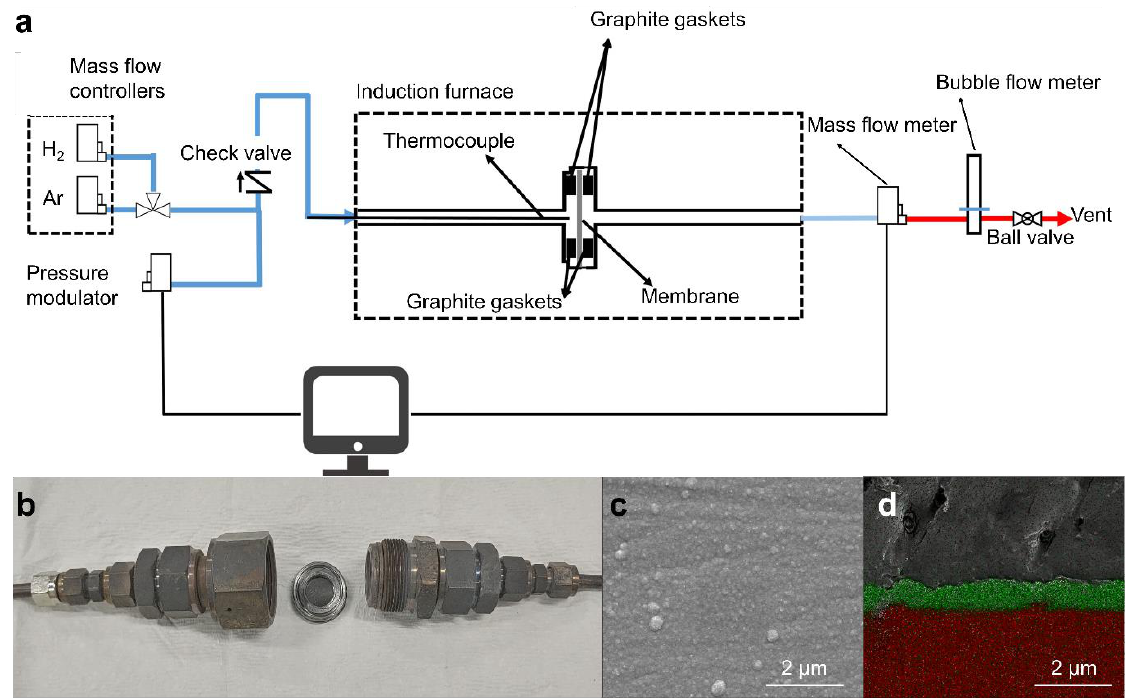
Figure 1. ( a ) Schematic diagram and photograph of H 2 permeation system, ( b ) reactor and its parts, ( c ) SEM image of the surface, and ( d ) EDS mapping of cross-section of Pd on Ta support: green — Pd, and red — Ta .